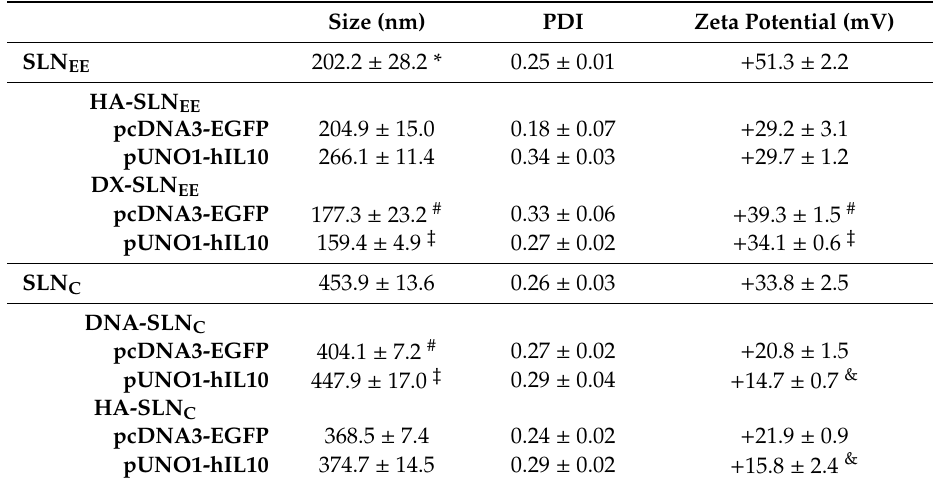
Table 2. Physical characterization of nanoparticles and SLN EE - and SLN C -based vectors bearing the plasmid pcDNA3-EGFP or the plasmid pUNO1-hIL10. Size (nm)